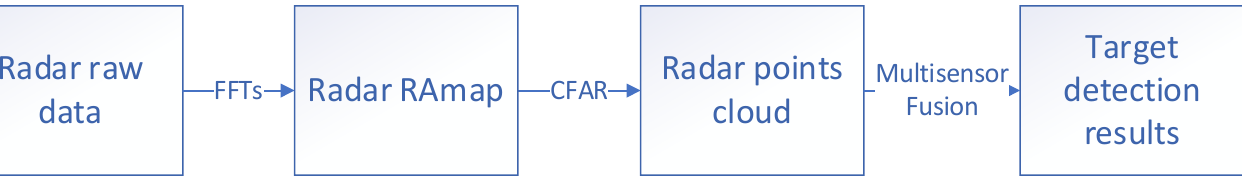
Figure 1. CFAR-based radar target-detection flow chart.